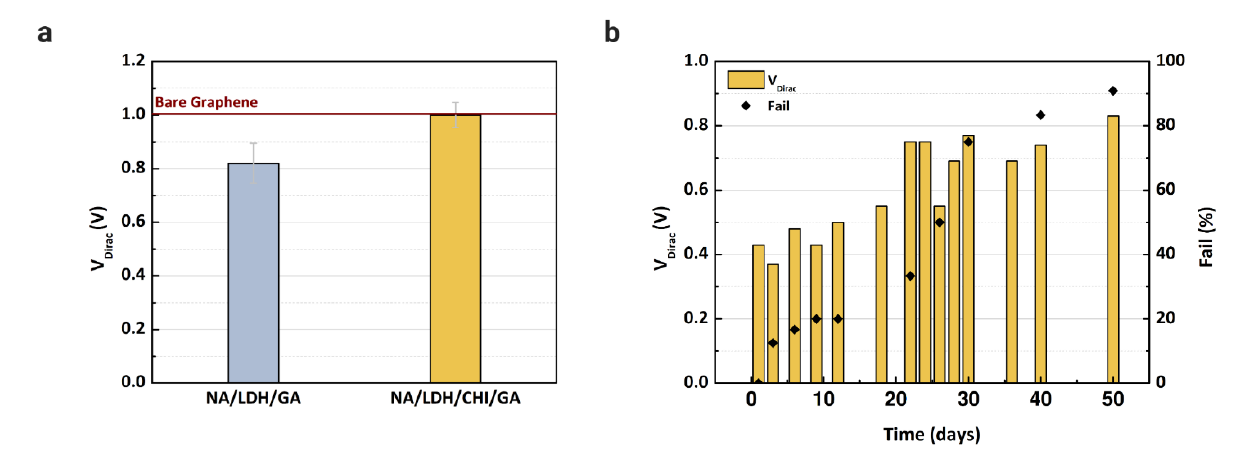
Figure 6. Dirac point voltage values of GFET devices: ( a ) Using Nafion (NA), chitosan (CHI), and glutaraldehyde (GA) to immobilize and stabilize the LDH enzyme over the graphene layer; ( b ) Dirac point voltage values and the failure percentage measured during the stabilization experiment to evaluate the device for up to 50 days after immobilization of the enzyme. A concentration of 5 mM of L-lactic acid in buffer solution was injected into each channel.